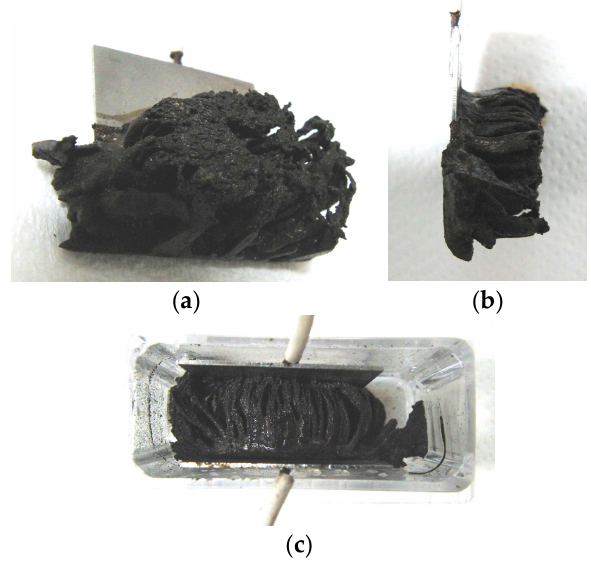
Figure 6. Photographs of solidified MCF rubber with large mass concentration: ( a , b ) attracted on the anode; ( c ) between the electrodes.